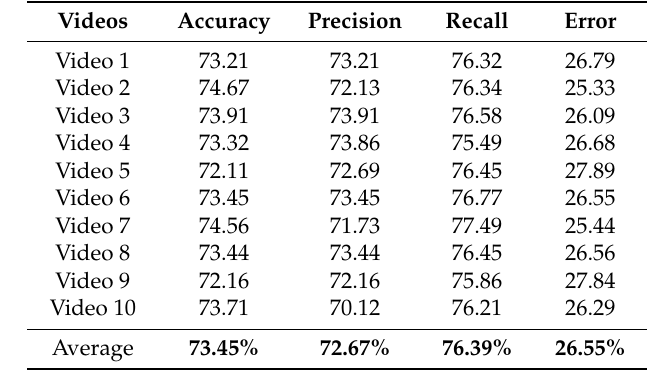
Table 7. Performance evaluation using extreme learning machine classifier with local binary pattern features.